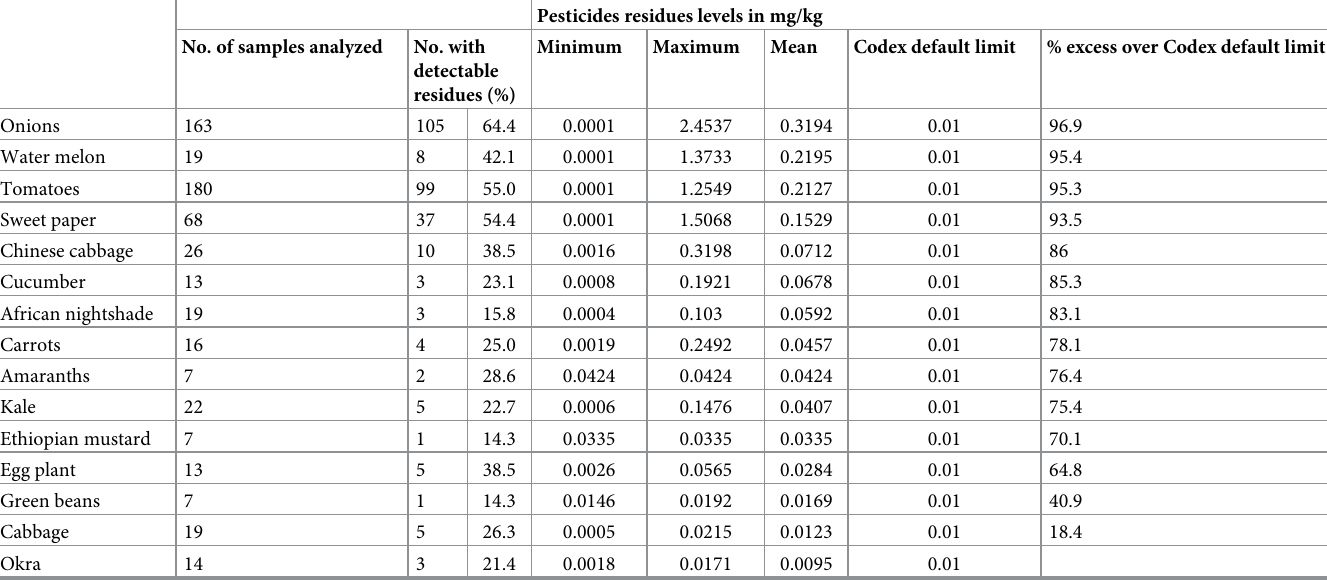
Table 5. Pesticides residue excess over Codex default limit.